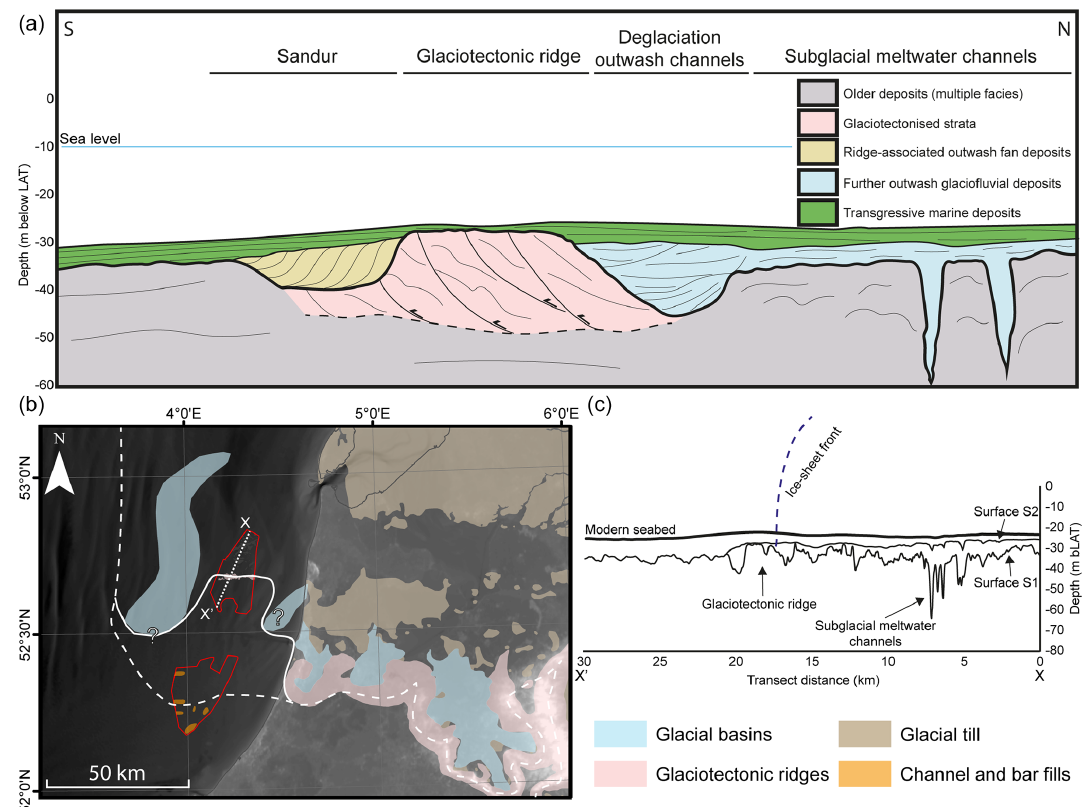
Figure 8. (a) Conceptual model of the infill (following transgression from MIS 6 to MIS 5e, but before the highstand) showing the main glacial geomorphological features and sediments preserved in the HKN wind farm. (b) Comparison between the previously inferred maxi- mum Saalian ice sheet extent (dashed line, Hijma et al, 2012; Batchelor et al., 2019) and the new limit proposed in this study (solid line). Question marks indicate sectors where the limit is uncertain and more research is needed (see text for details). Channel and bar fills identified in the HKZ wind farm are also indicated (some of them formerly interpreted as glaciotectonic ridges). Sources for onshore and offshore fea- tures are as in Fig. 1. (c) Bathymetry profile through the HKN wind-farm area highlighting the glacial geomorphological features identified and the approximate position of the ice front during the maximum ice sheet